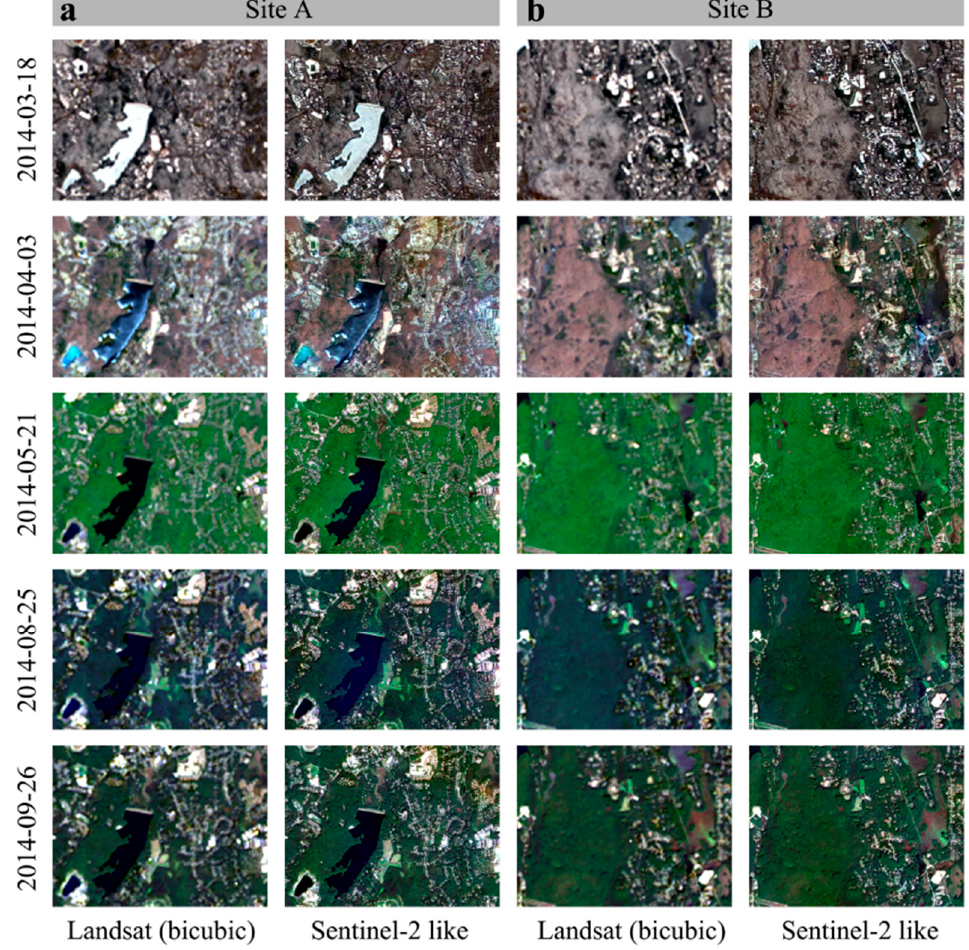
Figure 8. Super-resolution results of time-series Landsat images for capturing vegetation phenology over vegetated areas at site A ( a ) and site ( b ). From left to right: 10 m interpolation derived from Landsat using the bicubic method, and Sentinel-2-like reconstructed image derived from the GAN- based model.